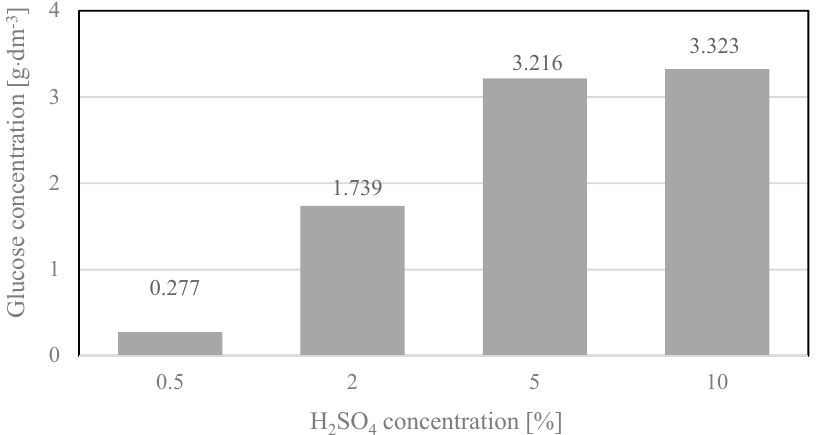
Figure 6. Glucose concentration in hydrolysates, depending on the concentration of the acid used. Reaction conditions 2 h, 120 °C. Glucose concentrations were the arithmetic means of the results obtained in three hydrolysis processes with the standard deviations: 0.277 ± 0.055; 1.739 ± 0.157; 3.216 ± 0.154; 3.323 ± 0.263.